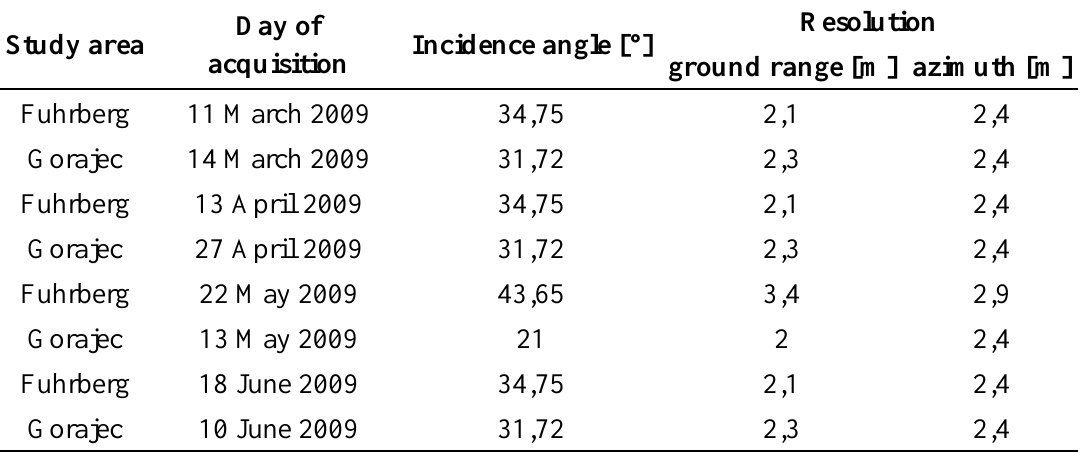
Table 1. Availability and incidence angle of TerraSAR-X images in the year